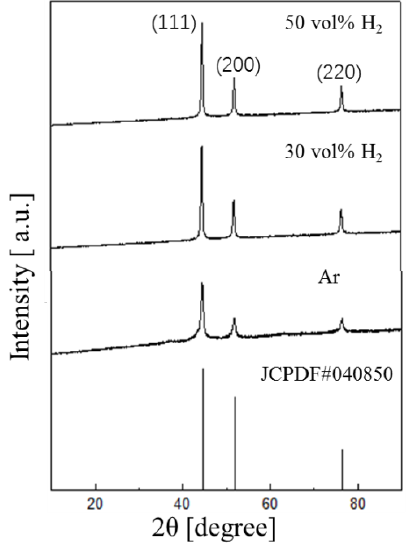
Figure 6. XRD patterns of nickel nanoparticle in argon arc at different hydrogen concentrations.